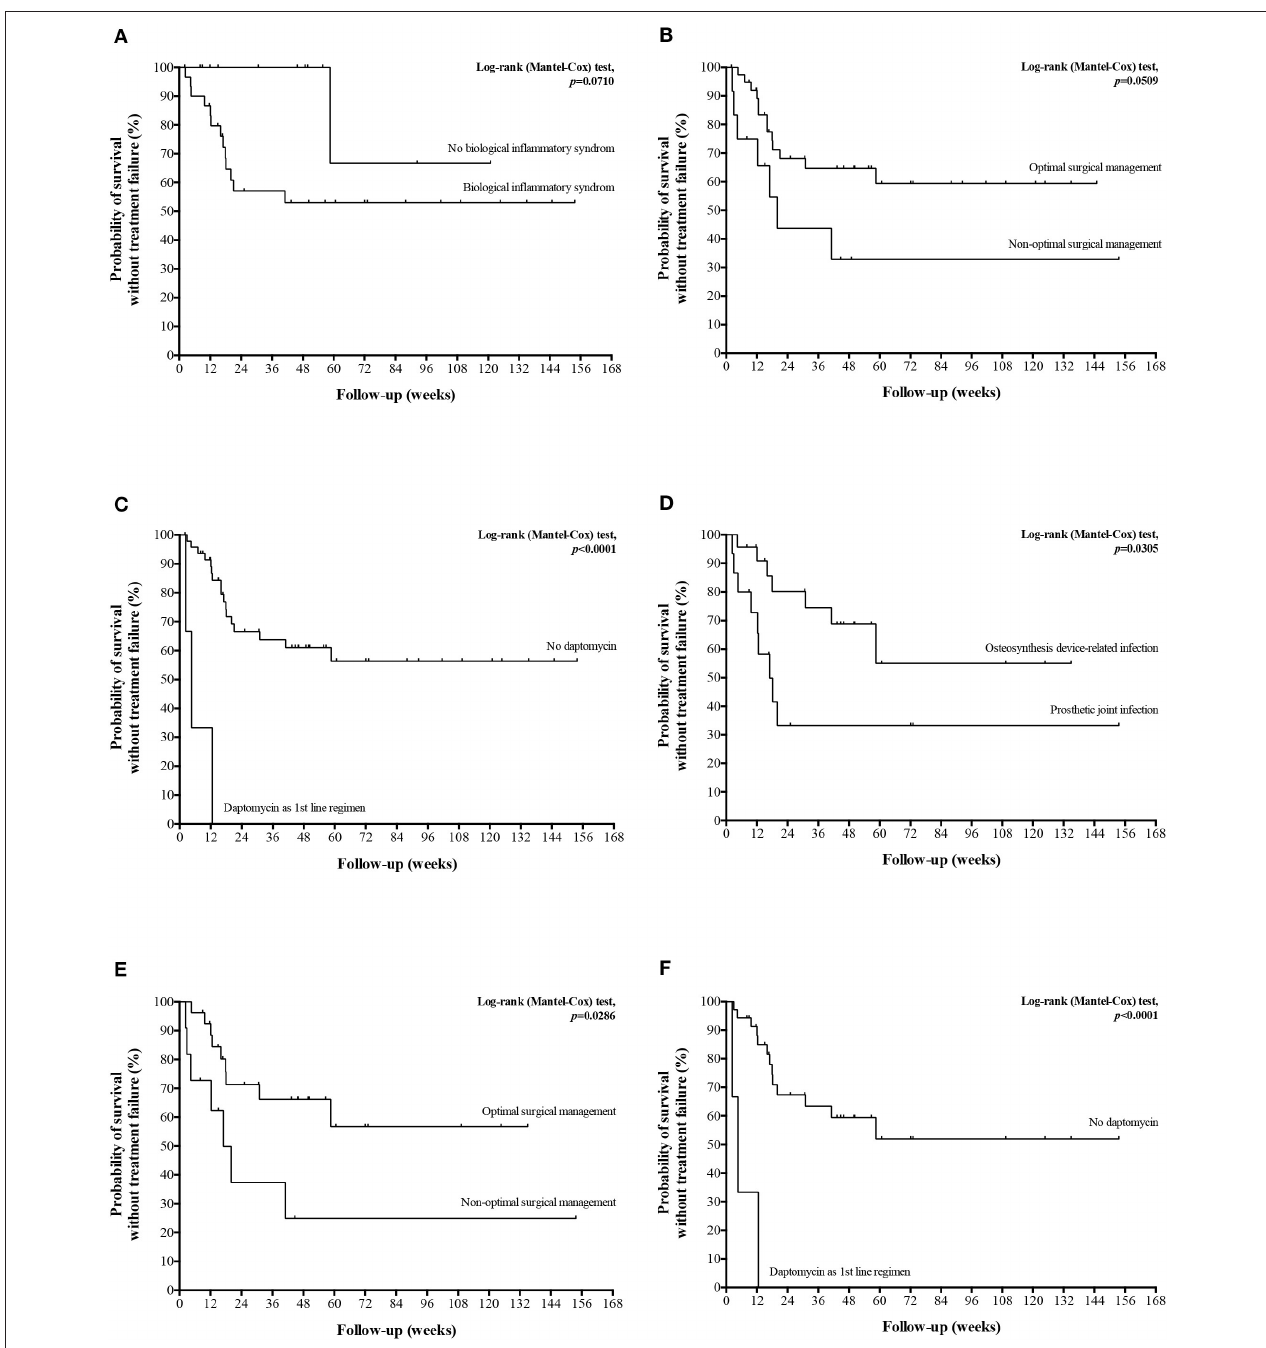
FIGURE 2 | Kaplan-Meier curves for the cumulative risk of treatment failure in all patients (A–C) and in patients with ODI panel (D–F) according to the major determinants of treatment failure.